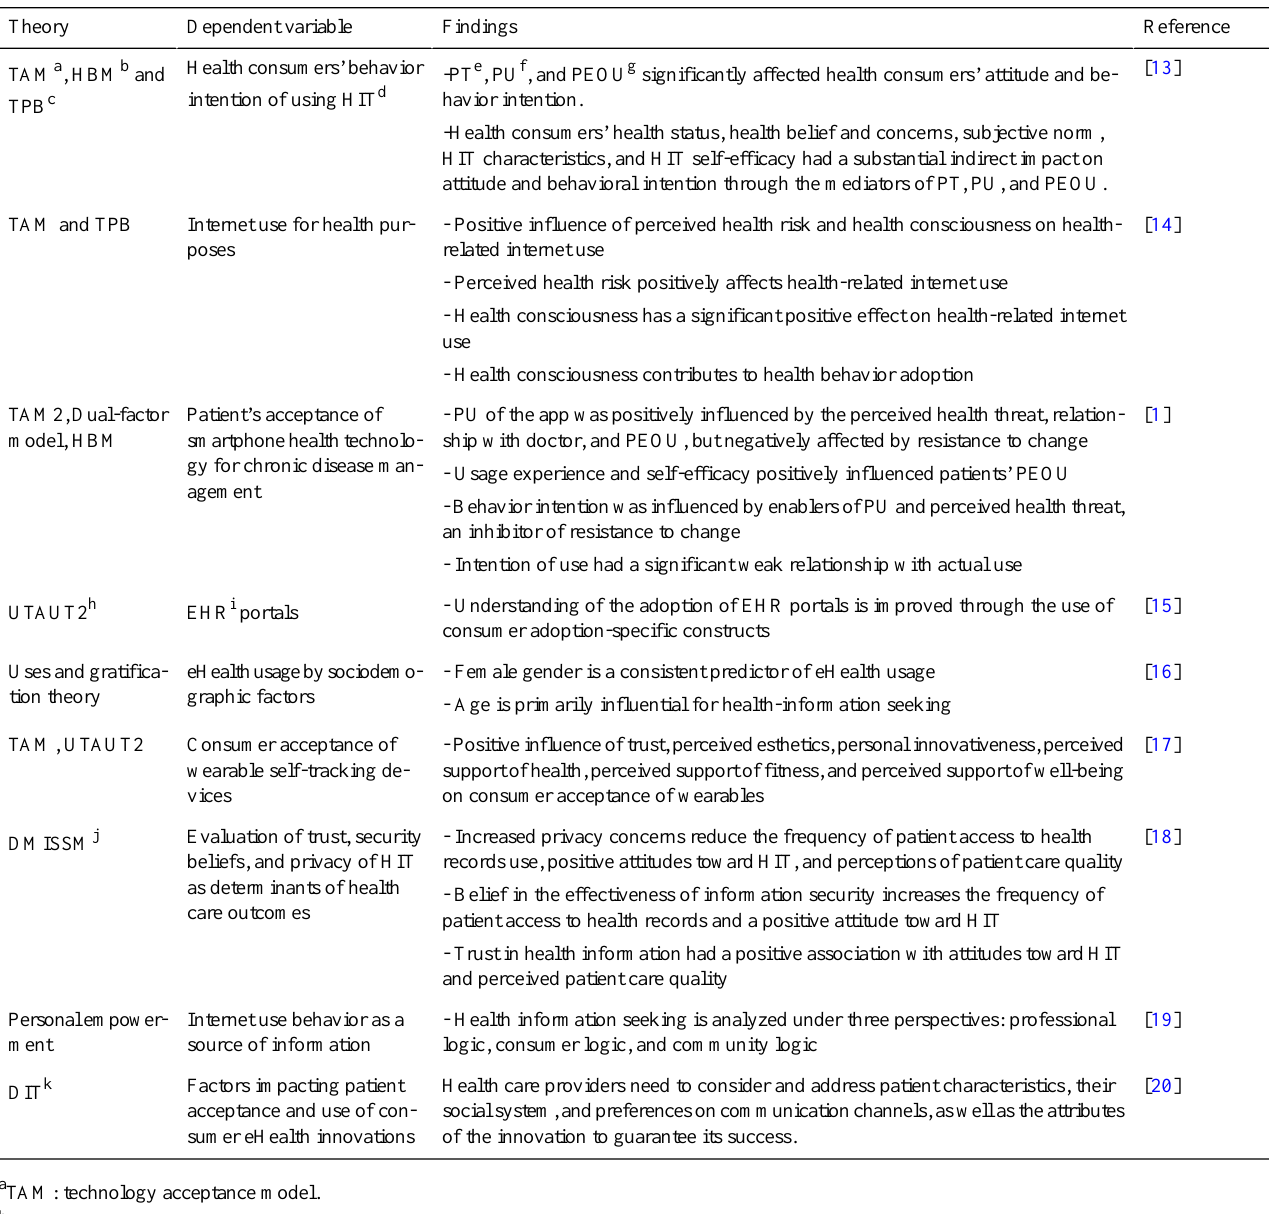
Table 1. Electronic health (eHealth) adoption models. ReferenceFindingsDependent